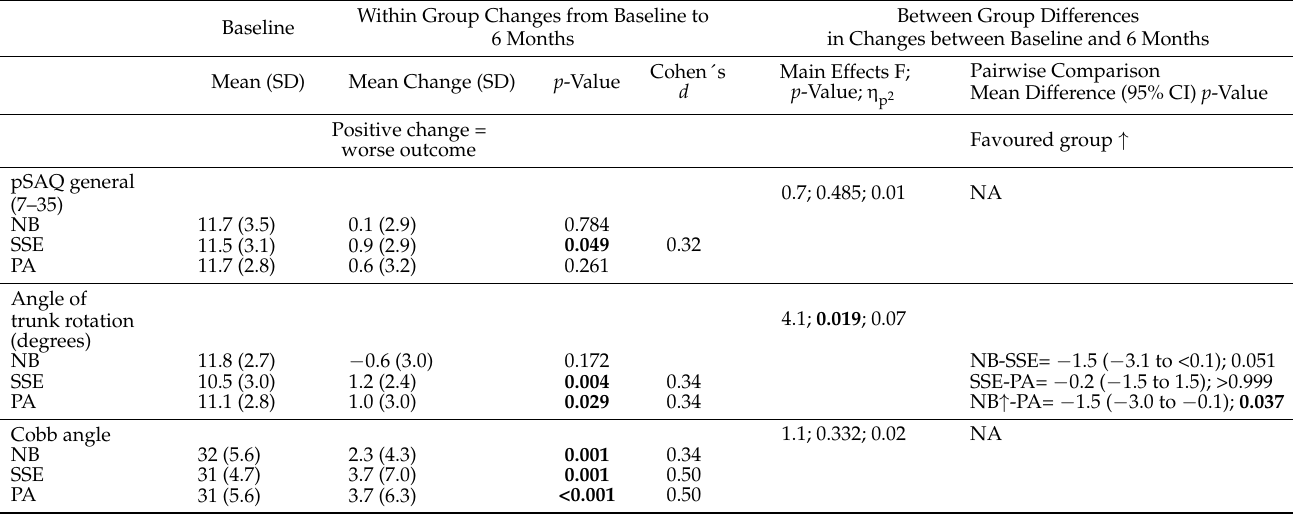
Table 4. Spinal appearance, angle of trunk rotation, and Cobb angles at baseline, within group changes from baseline to 6 months, and between group differences in changes from baseline to 6